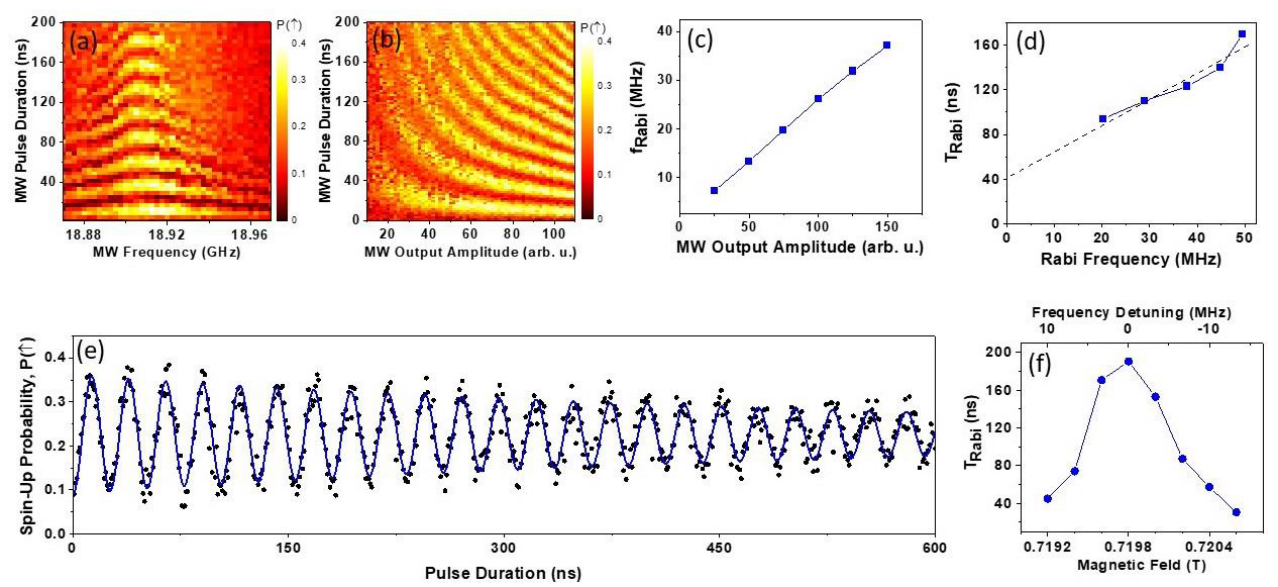
Figure 3. ( a ) Average spin-up probability to map out the Rabi oscillations as a function of the MW burst duration (Y-axis) and the MW frequency (X-axis); ( b ) the 2D map of the Rabi oscillations measured as the average spin-up probability in the plane of the MW Pulse Duration and MW Amplitude; ( c ) Rabi frequency as a function of MW pulse amplitude; ( d ) Period of Rabi oscillations as a function of Rabi frequency tuned by the MW burst amplitude; ( e ) An example of Rabi oscillations as a function of the MW burst duration; ( f ) Period of Rabi oscillations as a function of magnetic field stepped around the resonance frequency. The top scale shows effective frequency detuning. (For more details see text).